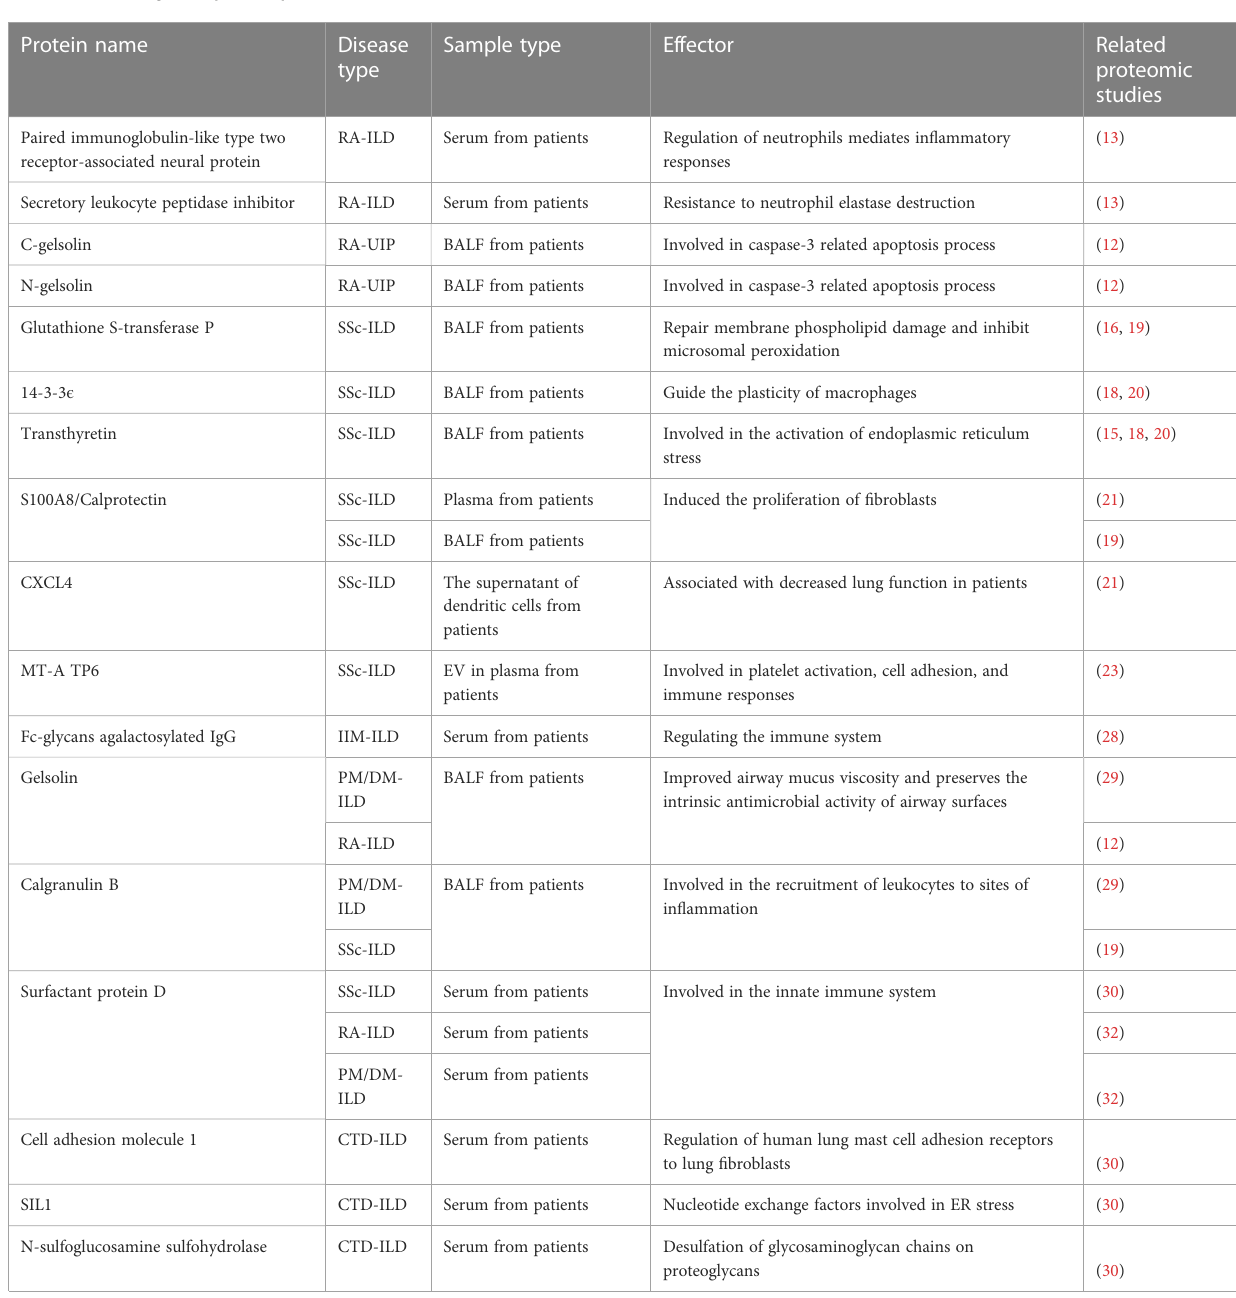
TABLE 2 Summary of important